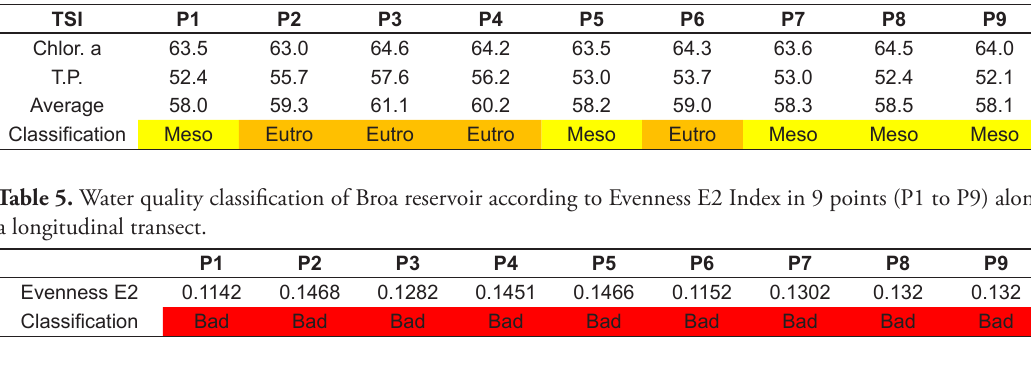
Table 4. Classification of Broa reservoir according Trophic State Index in 9 points (P1 to P9) along a longitudinal transect.